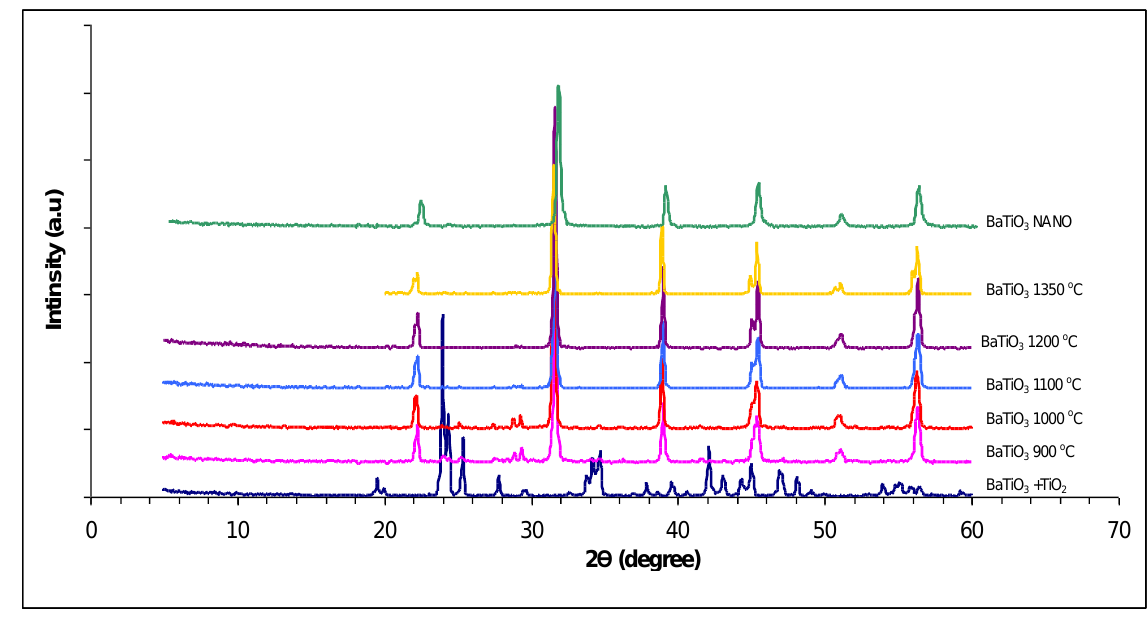
Figure 12: XRD pattern for pure micro & nano Barium Titanate with different temperatures.